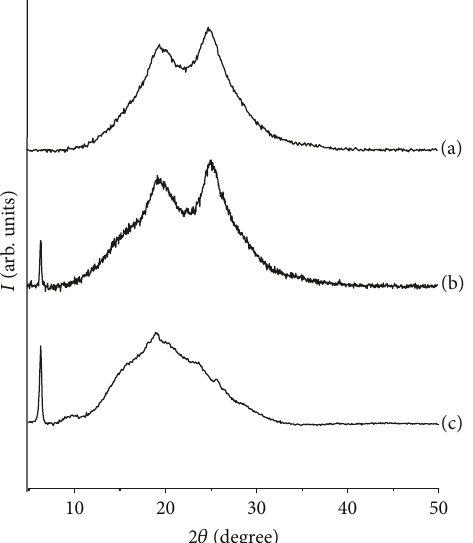
Figure 2: X-ray diffraction patterns of PANI powders prepared by simultaneous mixing of reagents, P1 (a), or dropwise addition of the oxidant, P2 (b), and by dedoping of P2 sample, P2d ( c ).